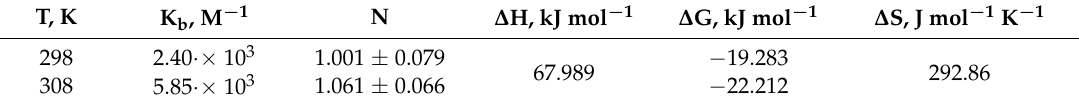
Table 4. The values of thermodynamic parameters for BSA binding with 4e at 298 and 308 K. T, K